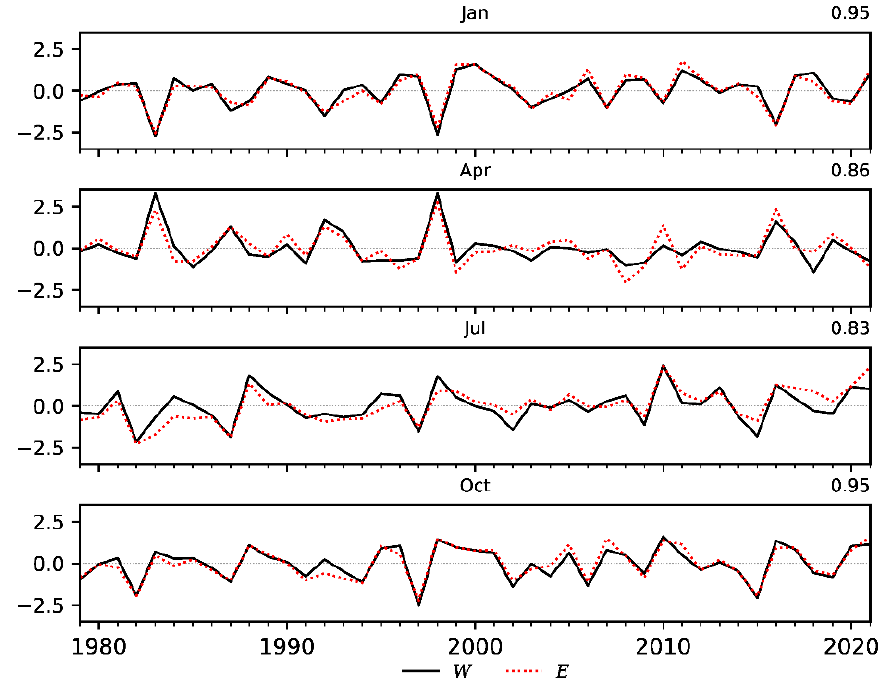
Figure 10. The principal component time series (PCs) of EOF 1 of PW and SVP was calculated with the ERA5 dataset (scaled to unit variance). The numbers at the top-right of subgraphs are correlation coefficients of two curves.